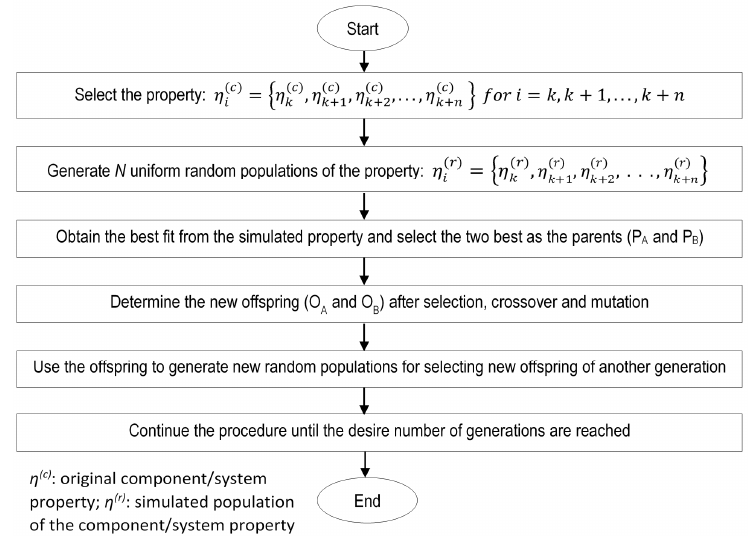
Figure 2. Procedure for estimating the properties of components and systems (C&S) using the GA.